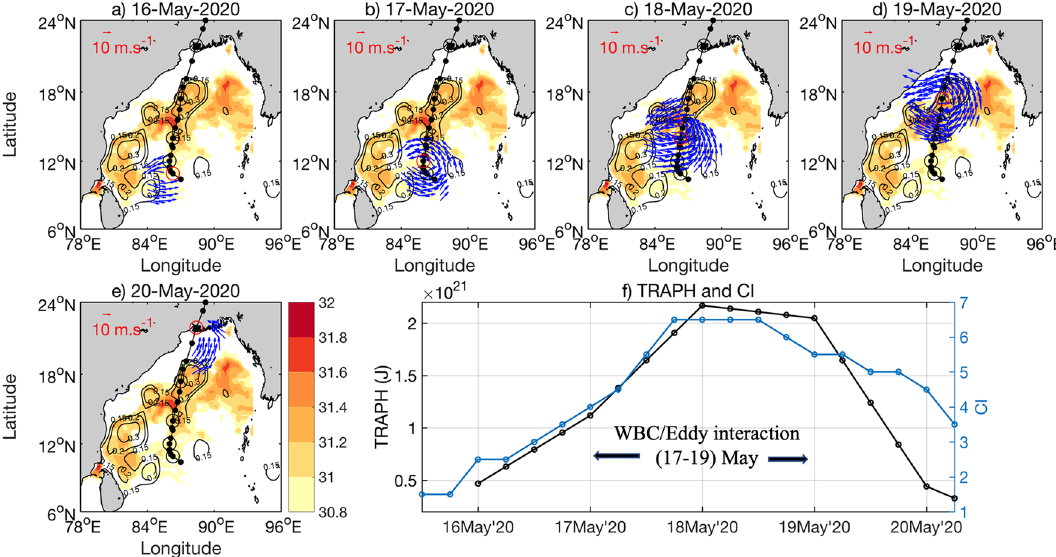
Figure 3. ( a–e ) Evolution of cyclone Amphan during 16th, 17th, 18th, 19th, and 20th May 2020, respectively. Background shaded SST and SSHA (contours) are for 15th May 2020 (for SST > 30.8 ◦ C ). The SSH contours in black show the WBC and the three anticyclonic eddies (high SSH values of 0.15 m). The blue wind vectors are for wind speeds more than 15 m s −1 . The black dots along the tracks represent the position of the cyclone center. ( f ) The two lines in the right-bottom panel are: (i) blue for CI of cyclone and (ii) black for the representative heat index (in Joule) available for cyclone intensification (TRAPH). See text for details. The black dots indicate the location of cyclone every 6 h. The black open circles indicate the positions of the Cyclone on each day (at 1200 UTC) during its whole journey. The red circle in each panel shows the location of the cyclone on that particular day at 1200 UTC. The interaction period between the cyclone with the WBC and its warm anticyclonic eddies are indicated by the horizontal arrows. The maps (coastlines) are created with Matlab M_Map v1.4 toolbox (https:// www. eoas. ubc. ca/ ~rich/ map. html).